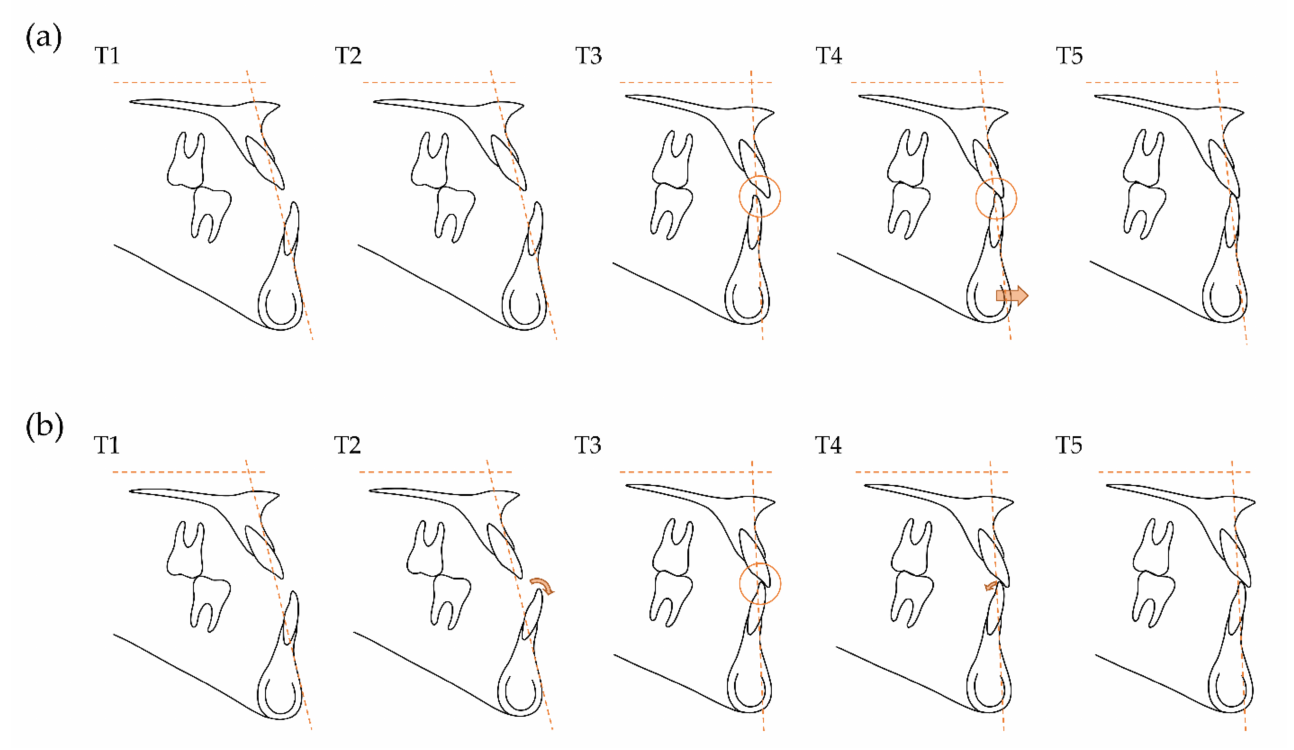
Figure 4. Schematic diagram of dentoskeletal changes of normal bracketing group (NB) ( a ) and reverse bracketing group (RB) ( b ). The horizontal dashed line represents the Frankfort horizontal plane and the oblique vertical dashed line represents the line connecting points A and B. Arrows indicate the difference in dentoskeletal changes between the two groups. Although both groups undergone similar skeletal changes during orthognathic surgery, the decompensation of the mandibular incisor inclination during presurgical orthodontic treatment was insufficient in NB, resulting in a larger overjet and looser interincisal contact compared to RB at postsurgery. Both groups experienced anteroposterior relapse during postsurgical orthodontic treatment, but NB had more anteroposterior skeletal relapse than RB without significant change in mandibular incisor inclination change: T1, pretreatment; T2, presurgery; T3, postsurgery; T4, posttreatment; T5,